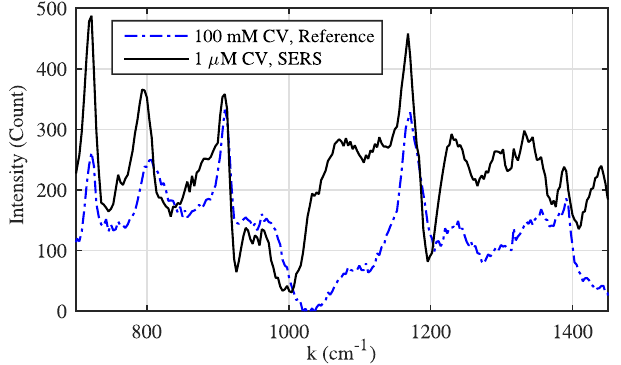
Figure 7. SERS Enhancement of crystal violet (CV) solution: 1 μ M crystal violet solution on Cu anode after 3 minutes of electrolysis compared to 100 mM reference Raman measurement. All recordings were done in 1 sec with 250 mW of laser power. For example, the Raman peak of CV at 1175 cm − 1 is enhanced for more than 10 5 .